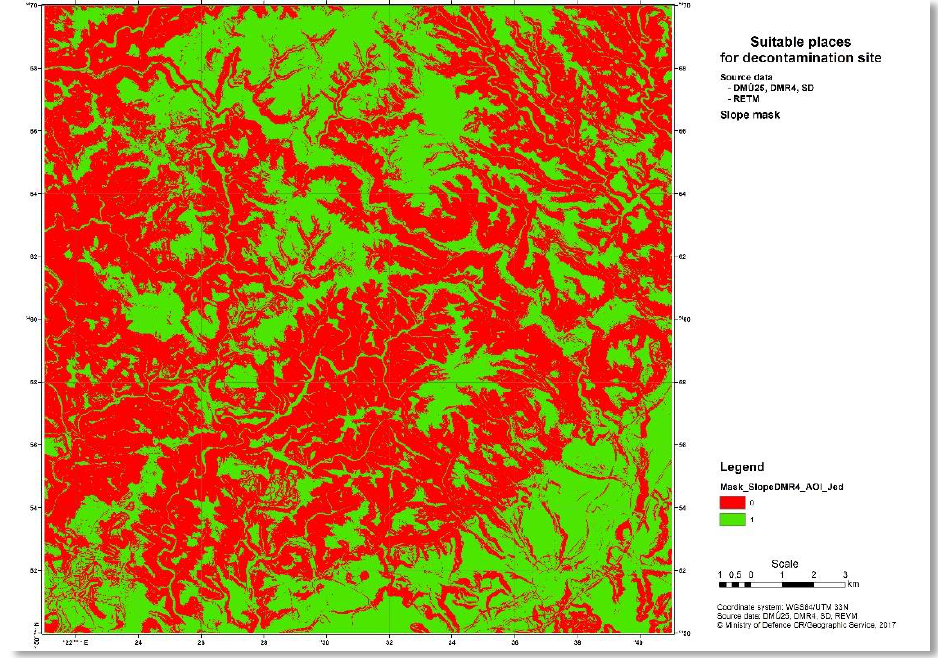
Figure 3. Raster file of slope inclination mask.